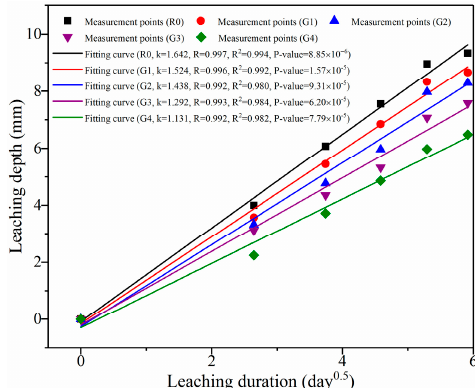
Figure 6. Linear fitting of the leaching depth of the samples in relation to the square root of the leaching duration. Note: the equations of the fitting curves of R0, G1, G2, G3, and G4 are y=1.642x– 0.083, y=1.524x–0.156, y=1.438x–0.263, y=1.292x–0.204, and y=1.131x–0.300.